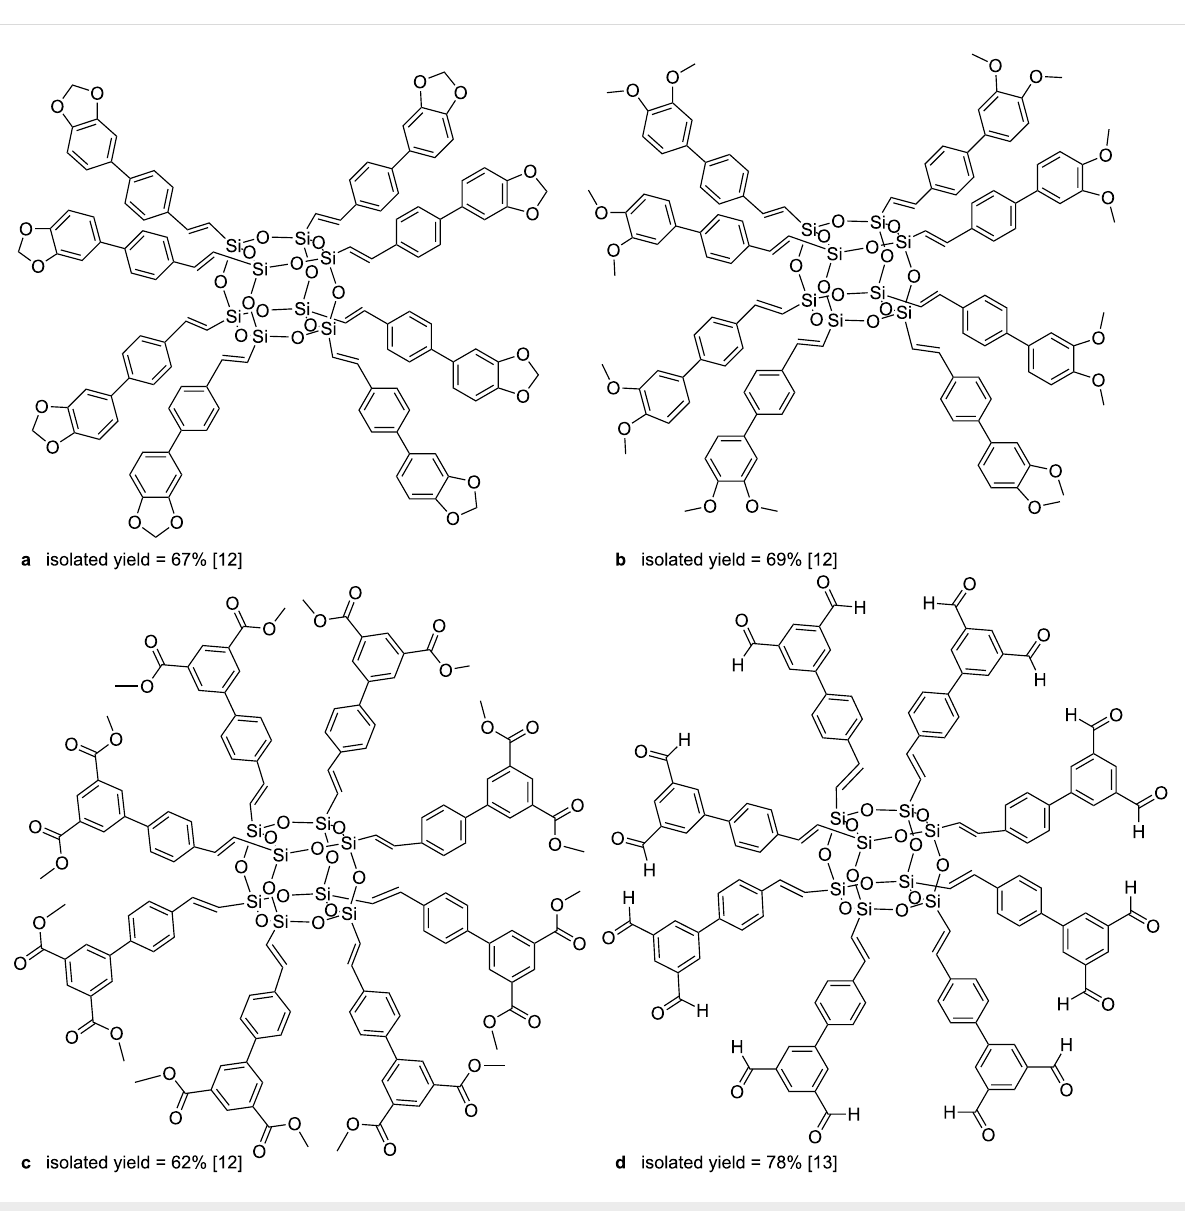
Figure 5: Vinylbiphenyl chromophore-decorated cubic silsesquioxanes.